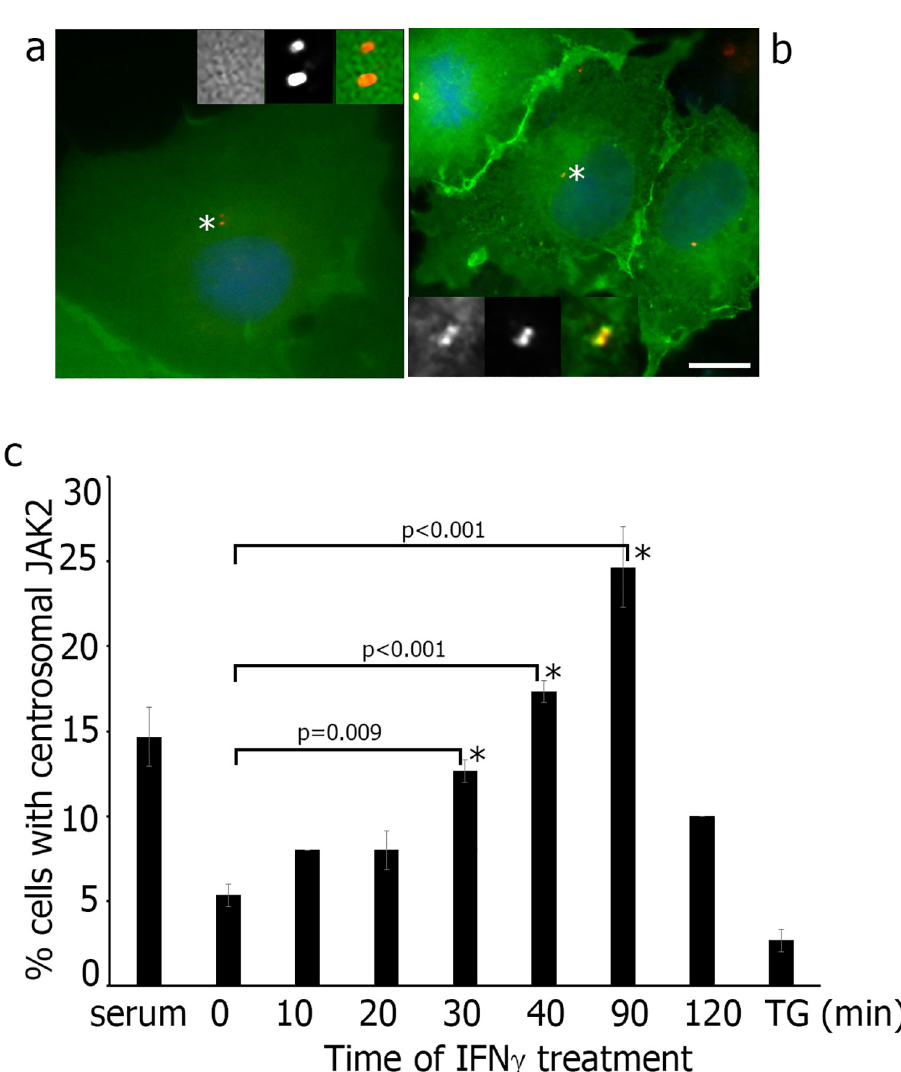
Fig 3. IFN γ treatment causes re-localization of JAK2 to centrosome. ( a, b ) COS-7 cells overexpressing EGFP-WT JAK2 (green) were serum deprived, treated with IFN γ , fixed and labeled with anti-centrin 1 (red) for centrosome localization. Image in (a) represents centrosome which is not labeled for JAK2 and image in (b) represents the centrosome labeled with JAK2. ( c ) The number of EGFP-positive cells with centrosomal JAK2 (as in (b)) were scored and plotted. Cells grown in serum were used as a positive control. JAK2 was inhibited by incubation with 50 mM of TG 101209 for 48 hrs followed by treatment with IFN γ for 90 min (last right bar). 50 cells were assessed in each experiment for each time point. N = 3. Bars represent mean ± SE. � , P < 0.05 compared with untreated cells (0 min). Scale bar 8 μ m.